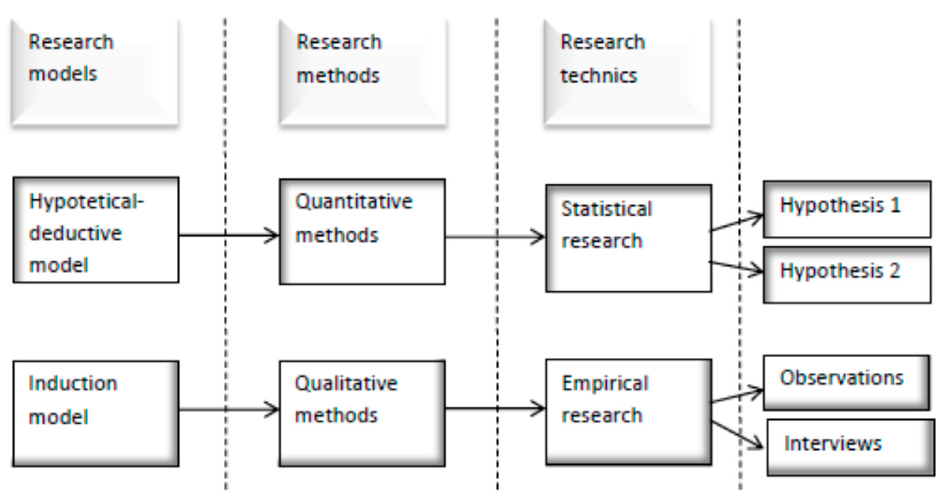
Figure 1. Conceptual framework for conducting research.